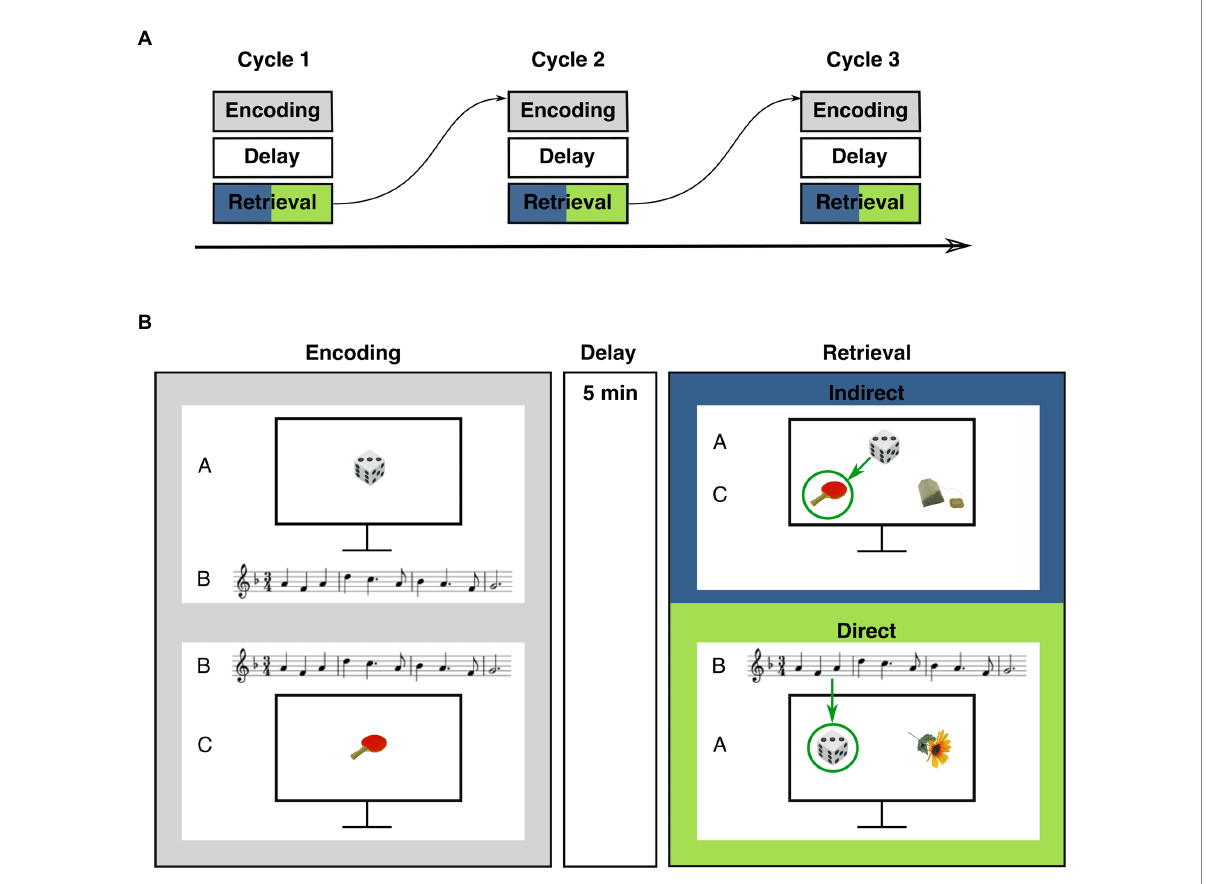
FIGURE 1 Procedure and example stimuli of the musical associative inference task. (A) Task structure: The experiment consisted of three alternating encoding and retrieval blocks that were separated by a delay of 5 min. (B) Example stimuli of encoding and retrieval blocks. During the encoding block, participants studied overlapping pairs of objects and melodies (AB-/BC-pairs) and non-overlapping DE-pairs (not shown). Note the overlapping melody of AB-/BC-trials. At retrieval, participants were tested on studied direct trials (AB-, BC-, and DE-pairs) and on indirect trials (inferential AC-pairs). Green arrows indicate the correct